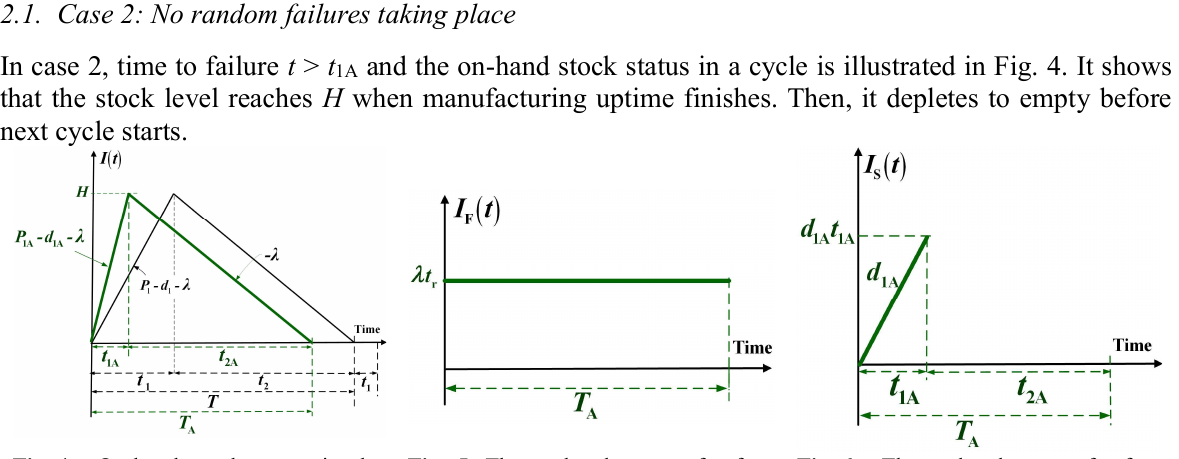
Fig. 6. The on-hand status of safety stocks in the proposed system with scrap and expedited rate, but without failures taking